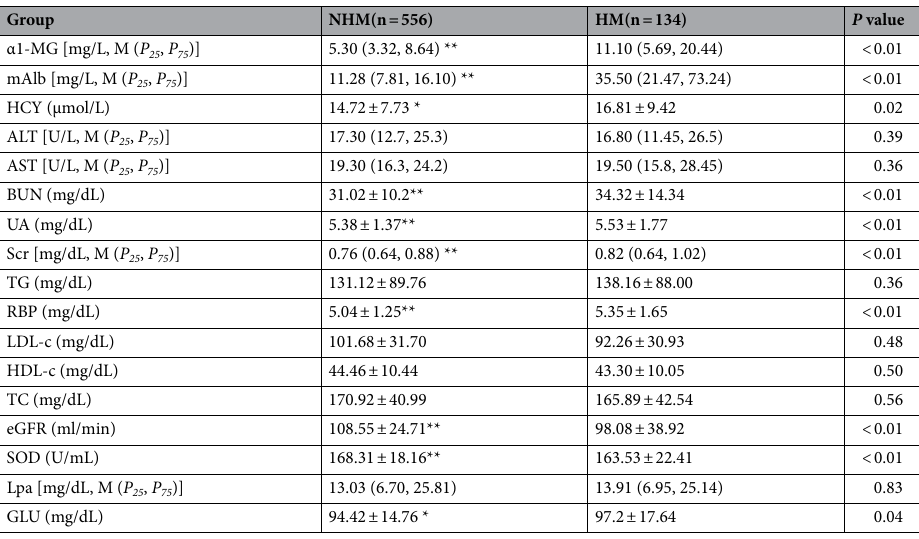
Table 2. Comparison of patients’ laboratory findings. The data are presented as mean ± SD for continuous variables and M ( P 25 , P 75 ) for incontinuous variables, n for categorical variables. α1-MG ɑ 1 -microglobin, mAlb Urinary microalbumin, Hcy Homocysteine, ALT Alanine aminotransferase, AST Aspartate aminotransferase, BUN Blood urea, UA Blood uric acid, Scr Serum creatinine, TG Triglycerides, RBP Retinol-binding protein, LDL-c Low density lipoprotein-cholesterol, HDL-c High-density lipoprotein cholesterol, TC Total cholesterol, Egfr Estimation of the glomerular filtration rate, SOD Superoxide dismutase, Lpa lipoprotein A, GLU Blood glucose. *significantly different from the HM group ( P < 0.05) **significantly different from the HM group ( P < 0.01).